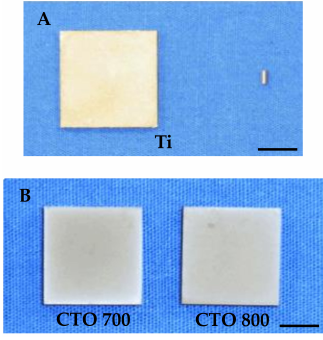
Figure 1. Specimen design for the in vitro and in vivo tests. ( A ) Square disks (10.0 mm per side) and cylindrical non-screwed implants ( ϕ 1.0 × 2.0 mm), made of cpTi; these were used for the in vitro and in vivo tests, respectively. ( B ) Square disks of CTO 700 (left) and CTO 800 (right). Bars = 4